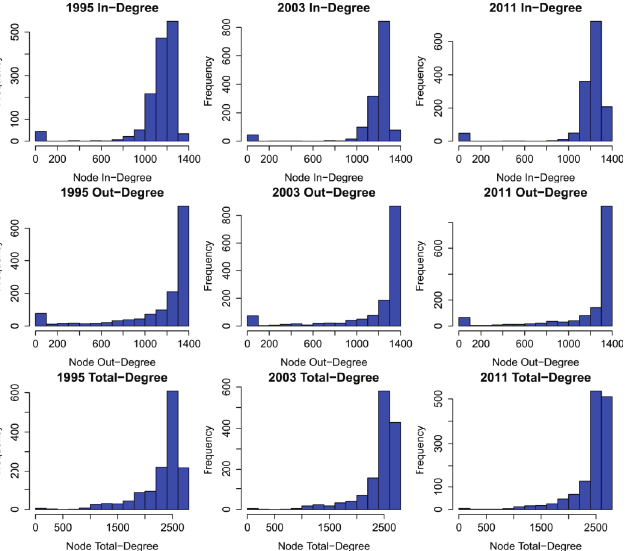
Fig 6. Histogram of in-degree, out-degree, and total-degree distributions for selected years. For the selected years 1995, 2003, and 2011, the first row has the in-degree distributions while the second row and the third row have the out-degree and total-degree distributions respectively. The WION is characterized by the highly left-skewed degree distributions. Most nodes enjoy high-degree connections in the WION due to the aggregated industry